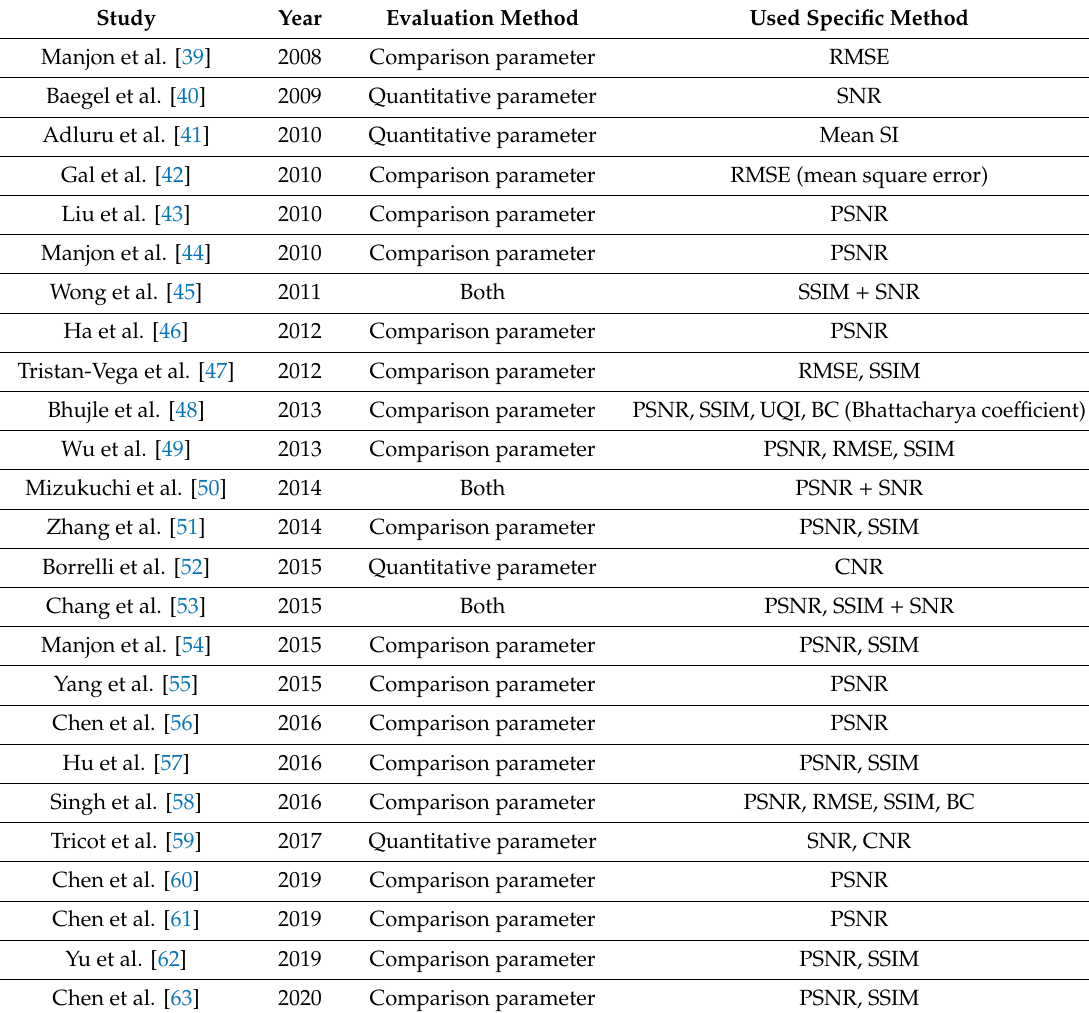
Table 5. Characteristics for the evaluation method of the NLM noise reduction algorithm in MR imaging, from studies retrieved for systematic